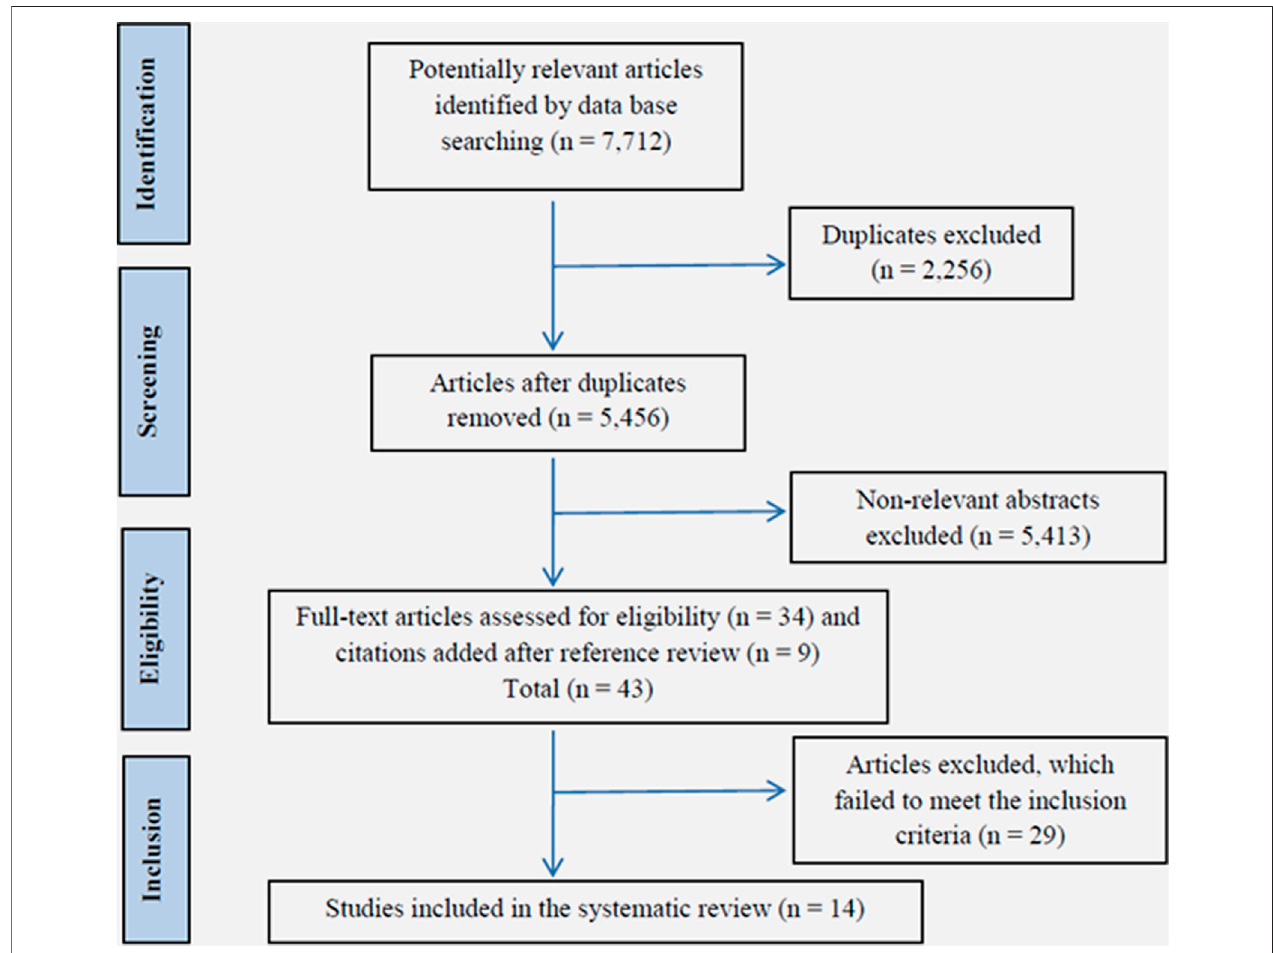
FIGURE 1 | Study fl ow